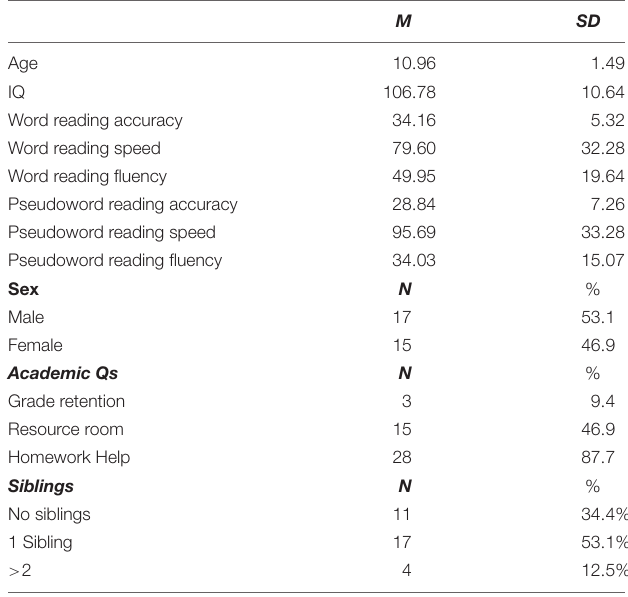
TABLE 1 | Characteristics of child participants.